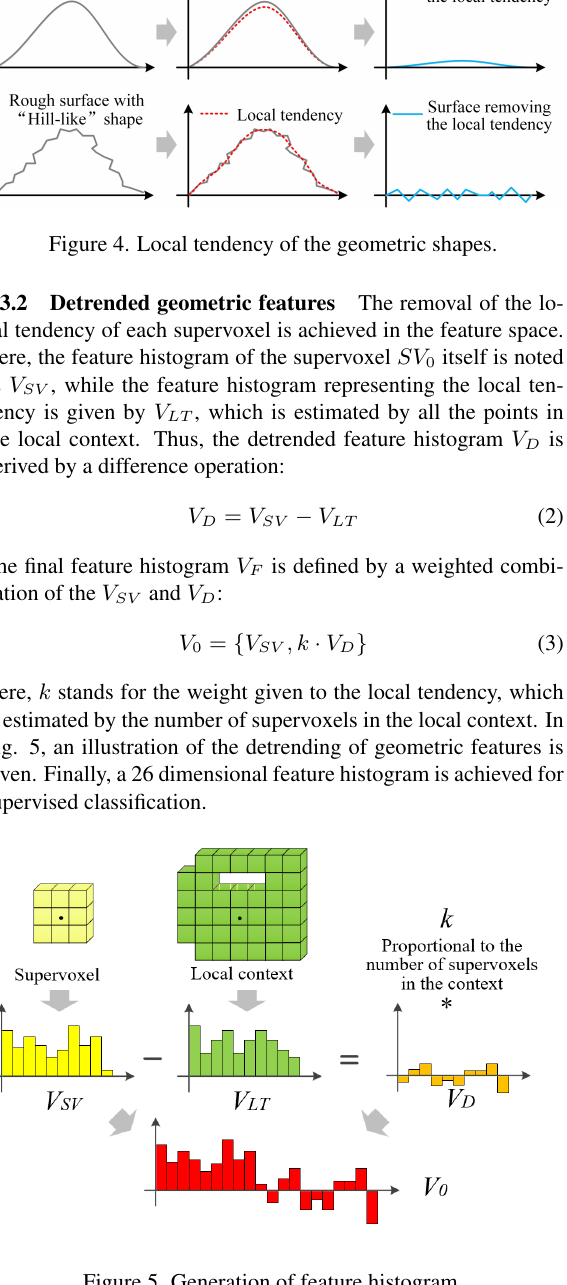
Figure 5. Generation of feature histogram.